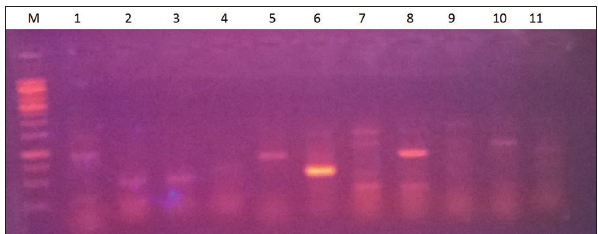
Figure-S2: Representative of multiplex polymerase chain reaction in identification of enterotoxigenic Escherichia coli and enteroaggregative E. coli using eltB/eltA and pCVD primers, respectively, Lane M , marker (1-kb DNA ladder) ; Lane 1-11 , E. coli